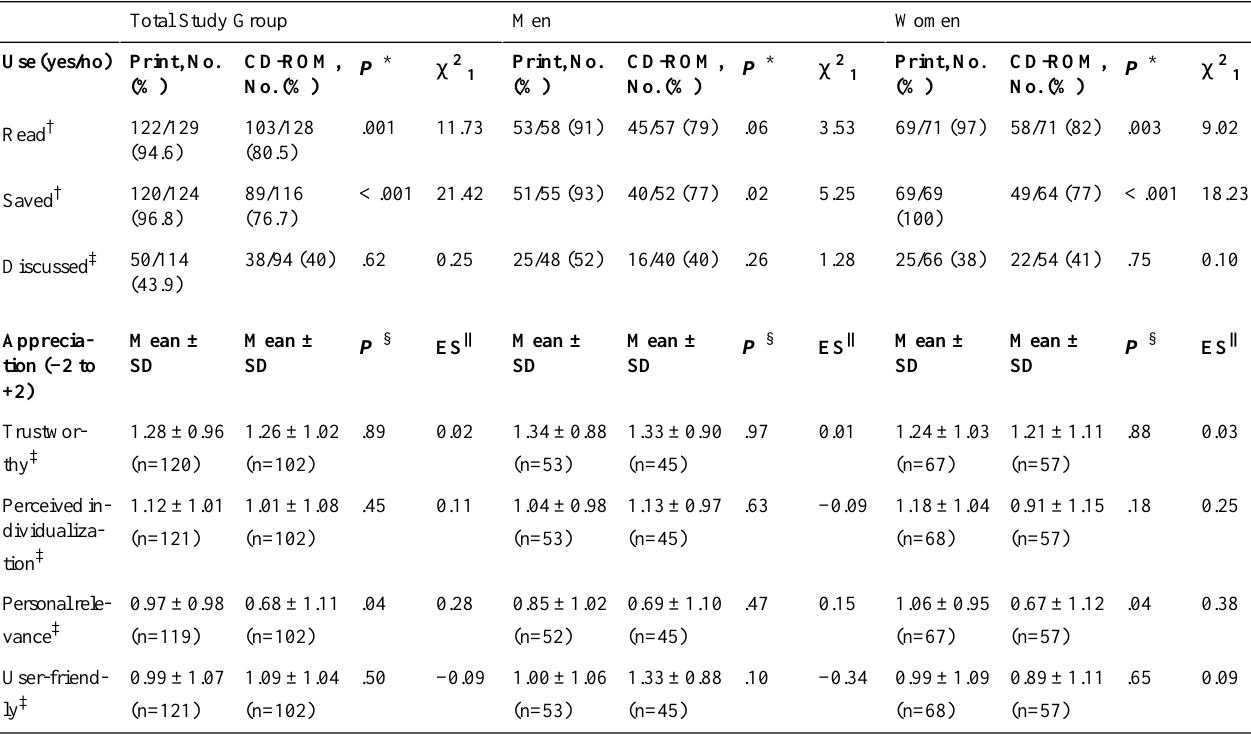
Table 1. Use and appreciation of the print- and CD-ROM-delivered, computer-tailored intervention, by